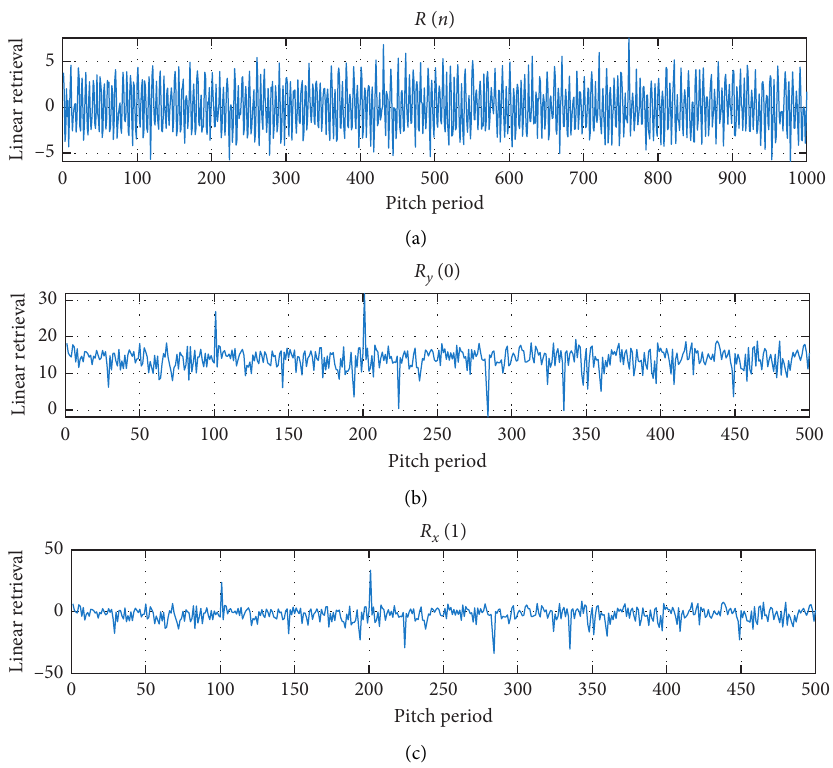
Figure 7: Retrieval effect diagram of speech signal after central clipping.